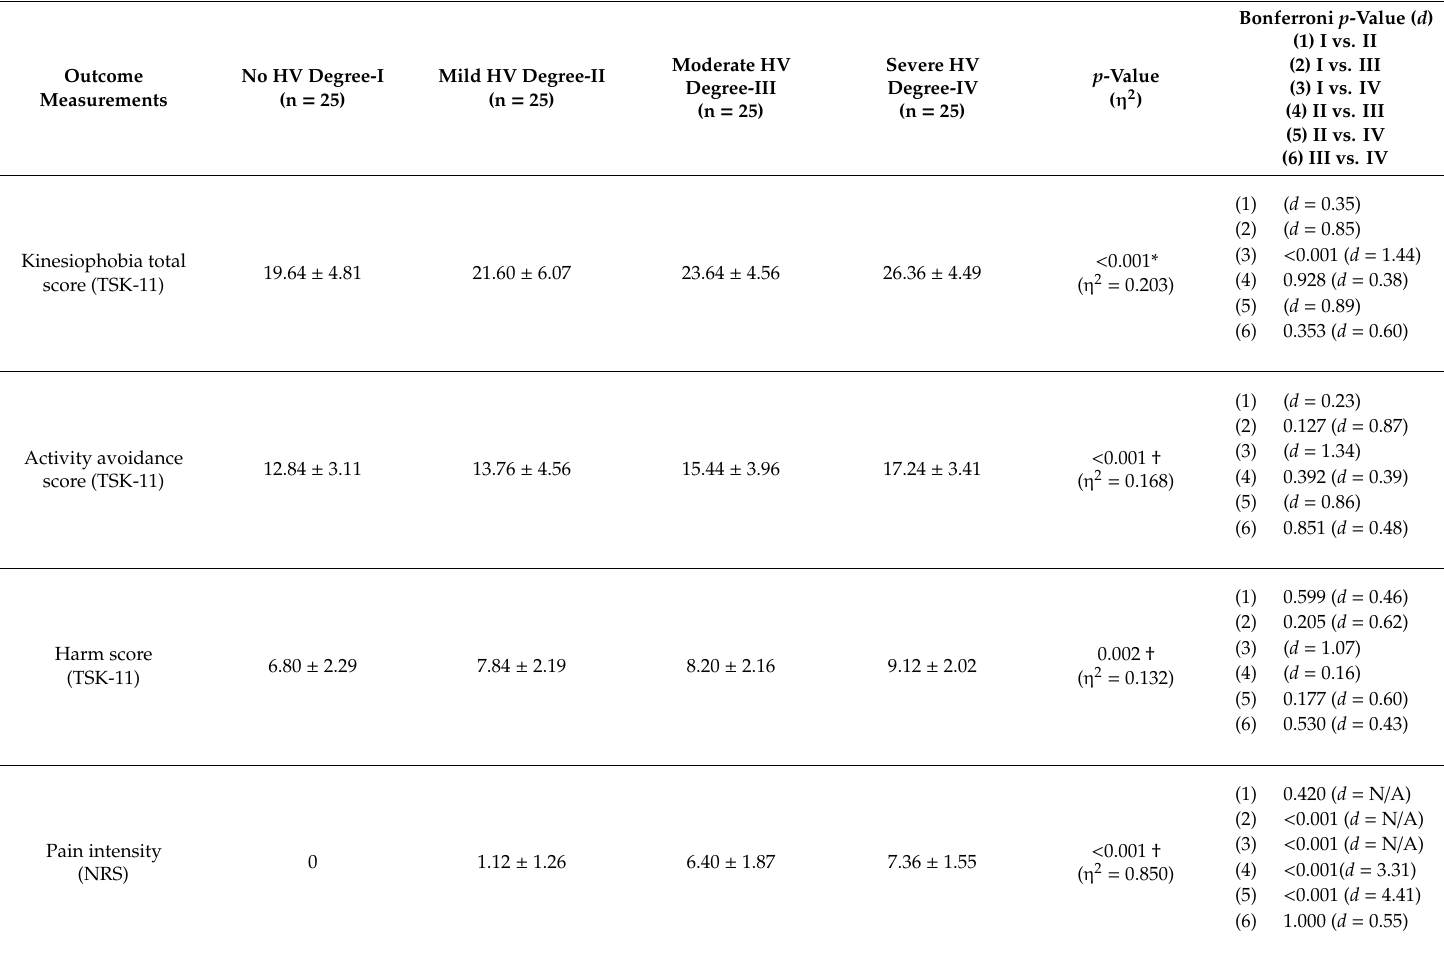
Table 2. Comparisons of outcome measurement scores among di ff erent HV deformity